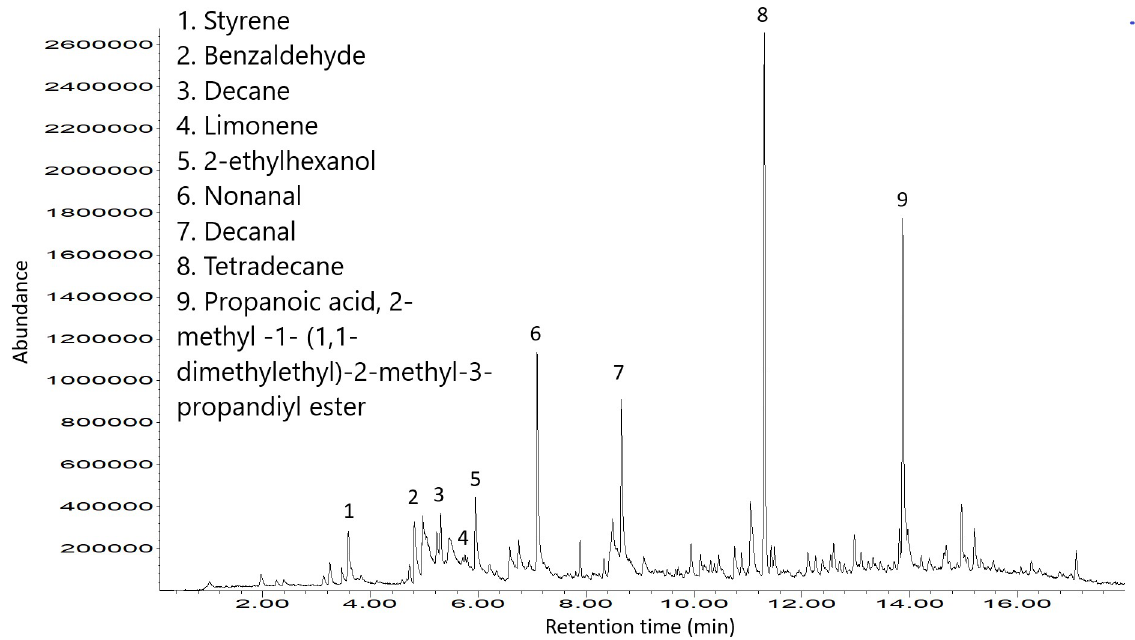
Fig 5. Total ion chromatogram of mucus sample with the most frequently occurring compounds labelled. Compounds are: 1 –styrene, 2 –benzaldehyde, 3 –decane, 4 –limonene, 5–2-ethylhexanol, 6 –nonanal, 7 –decanal, 8 –tetradecane, 9—propanoic acid, 2-methyl-1- (1,1-dimethylethyl)-2-methyl-3-propandiyl ester.